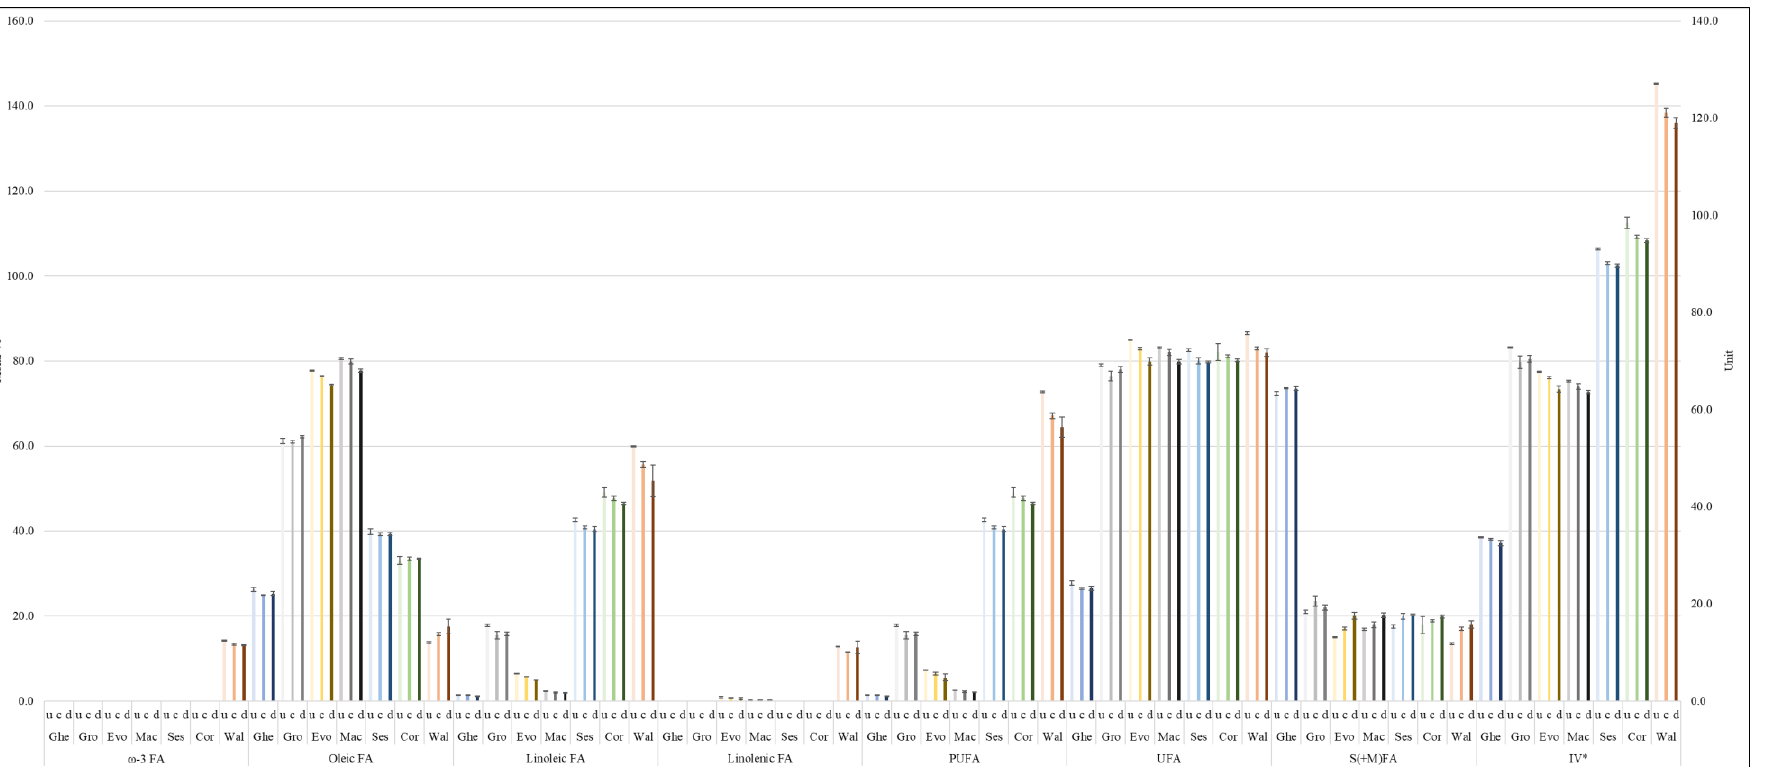
Figure 8. Modifications to FA groups and IVs in unheated and thermally stressed culinary oils exposed to continuous and discontinuous thermo-oxidation episodes conducted at 180 °C for 120 min. *IV is expressed in IV units. Abbreviations: u — unheated oil; c — continuous thermo-oxidation episode; d — discontinuous thermo-oxidation episode; Ghe — ghee; Gro — groundnut oil; Evo — extra virgin olive oil; Mac — macadamia oil; Ses — sesame oil; Cor — corn oil; Wal —walnut oil; ω -3 FA — omega-3 fatty acid; PUFA — polyunsaturated fatty acid; UFA — unsaturated fatty acid; S(+M)FA — saturated (and modified) fatty acid; IV — iodine value. The values are presented as mean ± SD molar % (FA) and mean ± SD IV units of each oil tested.